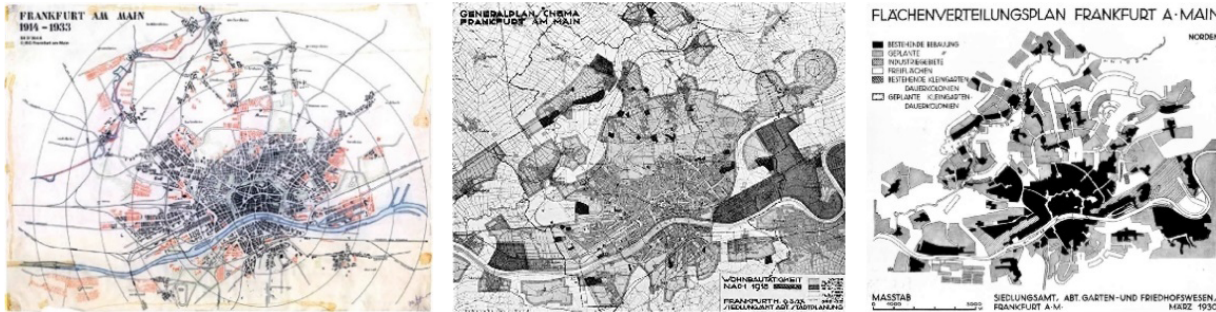
Figure 16. Frankfurt am Main. From left to right: housing construction 1914–1933; general construction plan after 1918; surfaces distribution plan of 1930. Source: Porotto